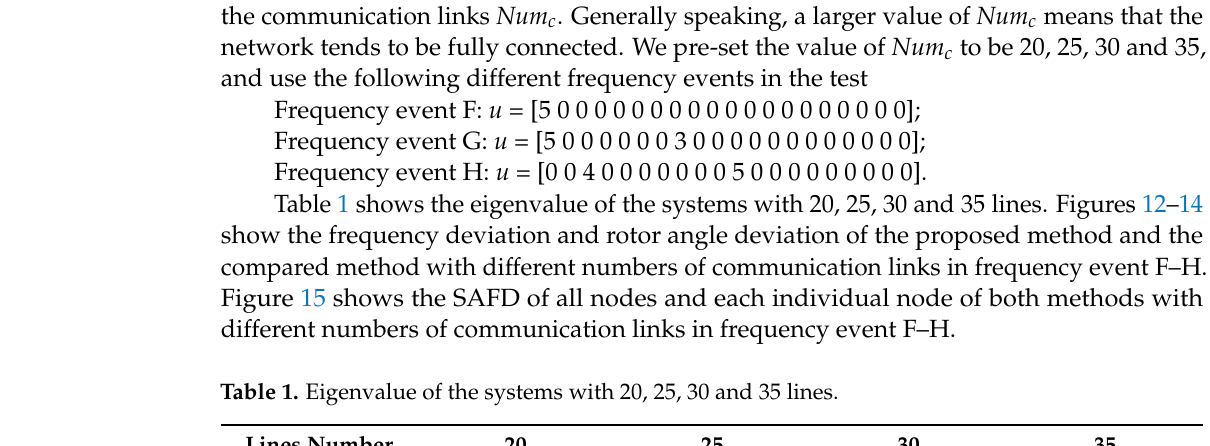
Table 1. Eigenvalue of the systems with 20, 25, 30 and 35 lines. Lines Number